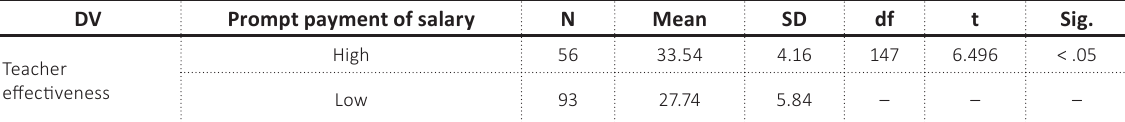
Table 3. T-test summary that shows the influence of prompt salary payment on teacher effectiveness DV